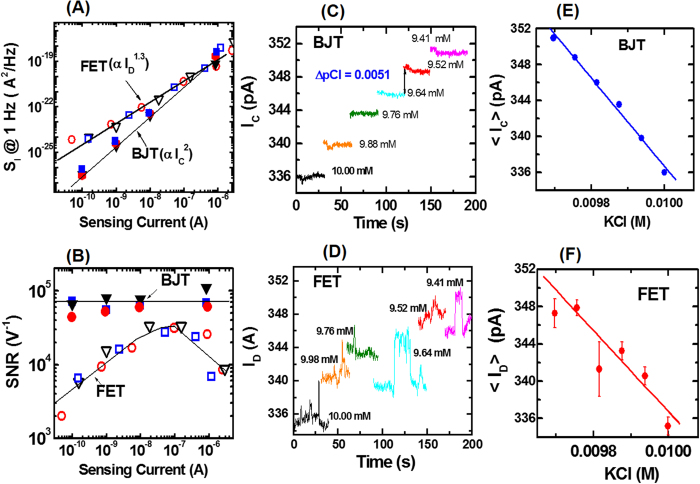
Sensing current noise power density (S1), signal noise ratio (SNR) and signal resolution comparison: (A) Dependence of SI at 1 Hz on sensing current for BJT and FET sensors; IC and ID are sensing currents for BJT and FET sensors, respectively; blue symbols denote S1 measured in 1 mM KCl, red symbols denote S1 measured in 100 mM KCL, and black symbols denote measurements made on a standard device with no sensing surface or solution; solid lines are power law fits and extracted exponent values are shown in the figure. (B) Comparison of SNR dependence on sensing current for BJT and FET sensors; blue symbols denote measurements made in 1 mM KCl, red symbols denote measurements made in 100 mM KCL, and black symbols denote measurements made on a standard device with no sensing surface or solution. (C) BJT sensor signal IC dependence as 10 mM KCl solution of 1.6 mL volume is diluted by adding 20 μL of deionized water at each step; IC is measured at a fixed VBE = 0.260 V. (D) FET sensor signal ID dependence on as 10 mM KCl solution of 1.6 mL volume is diluted by adding 20 μL of deionized water at each step; ID is measured at a fixed VG = 0.284 V. (E) Mean and standard deviation (error bar) values of sensing signal IC at various dilution steps; symbols denote mean IC (<IC>) estimated from BJT sensor data shown in (C); solid line is a power law fit. (F) Mean and standard deviation values of sensing signal ID at various dilution steps; symbols denote mean ID (<ID>) estimated from FET sensor data shown in (D); solid line is a power law fit.